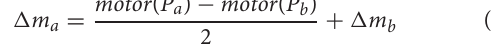
Frontiers in Neurorobotics |